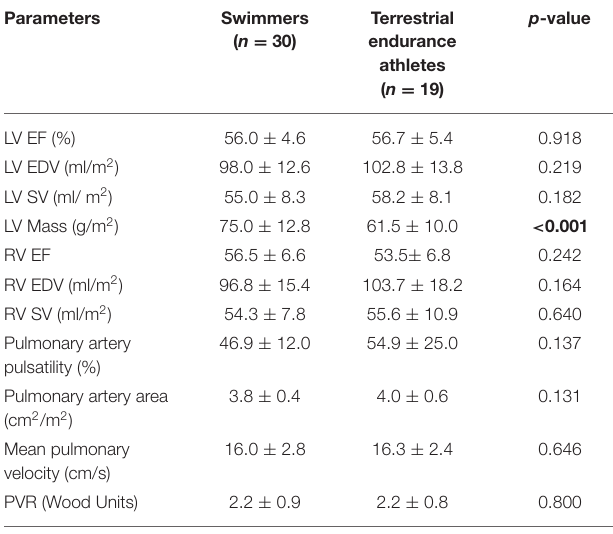
TABLE 3 | Cardiac magnetic resonance parameters comparation between swimmers and terrestrial endurance athletes.